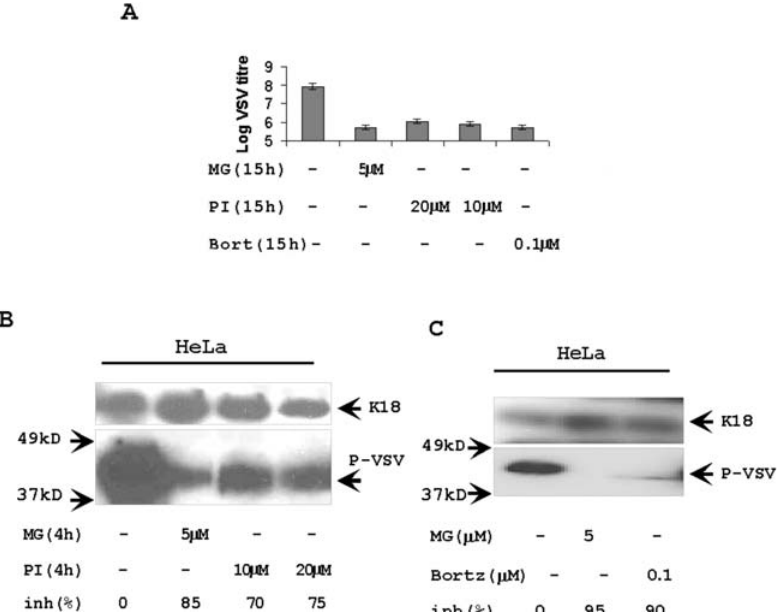
Figure3. Different proteasome inhibitors affect VSVreplication. (A)Proteasomeinhibitor1 andBortezomib decreasedVSVreplication.Titration of VSV from the medium of overnight infected HeLa cells. VSV infection (MOI=1) for one hour was substituted by the regular medium with indicated concentration of proteasome inhibitors. VSV was titrated by plaque assay after overnight growth. (B) Analysis of P-protein synthesis in the cells treated with proteasome inhibitor 1. HeLa cells were infected with VSV (MOI=5) for 4 h and treated with proteasome inhibitor 1 (PI) or MG132 (MG) at a time of VSV infection. The total protein extracts (5 m g) from these cells were analyzed by Western blotting with anti-P-protein Abs. The concentrations of proteasome inhibitors varied from 5 to 20 m M. Keratin 18 (K18) wasa protein loading control. (C) Bortezomib suppressedVSVreplication. HeLa cells were infected with VSV, treated with Bortezomib (100 nM) and MG132 (5 m M), and analyzed as described in panel B. K18 was a protein loading control.